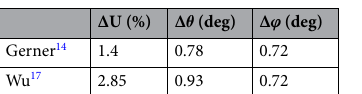
Table 4. Global deviation of traditional methods by different authors.